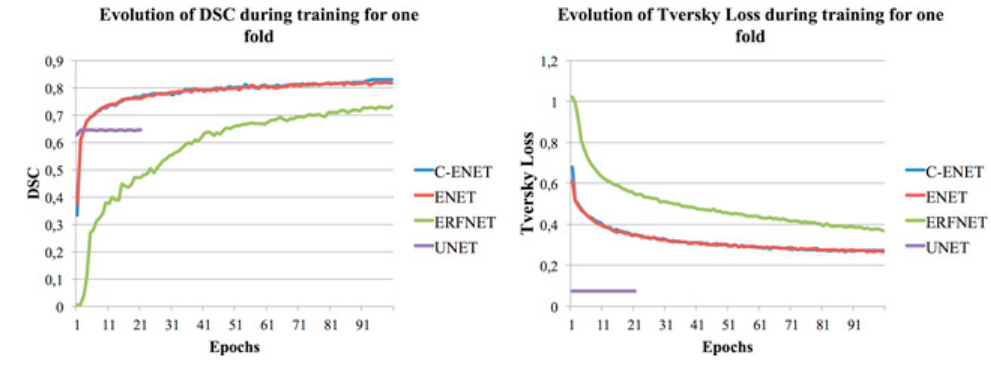
Figure 2. Training DSC and Tversky loss plots for C-ENET, ENET, ERFNET and UNET. Table 3. ANOVA on the DSC showed statistical differences between DL methods.